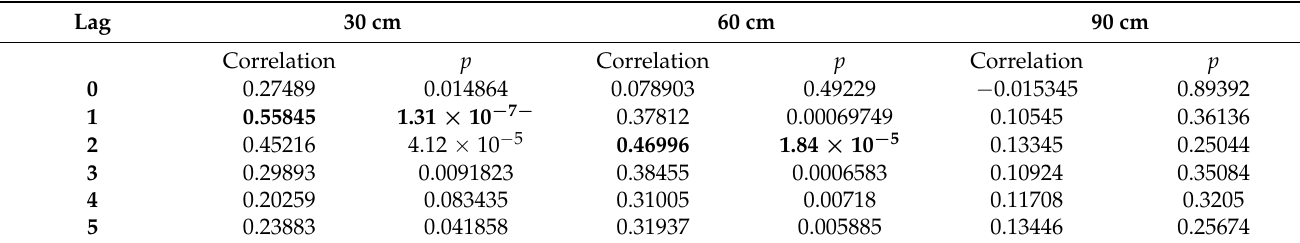
Table 5. Correlation between the input water (rain + irrigation) and the soil moisture at different depths (30, 60, and 90 cm). Cross-correlation and p values at different time (day) lag and soil depths. In bold, highly significant correlation values. Lag 30 cm 60 cm 90 cm Correlation p Correlation p Correlation p